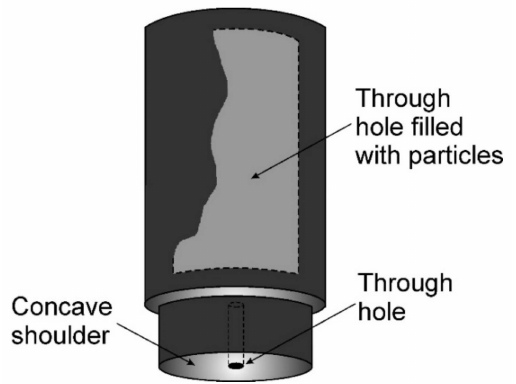
Figure 10. Direct friction stir-processing tool (authors’ own